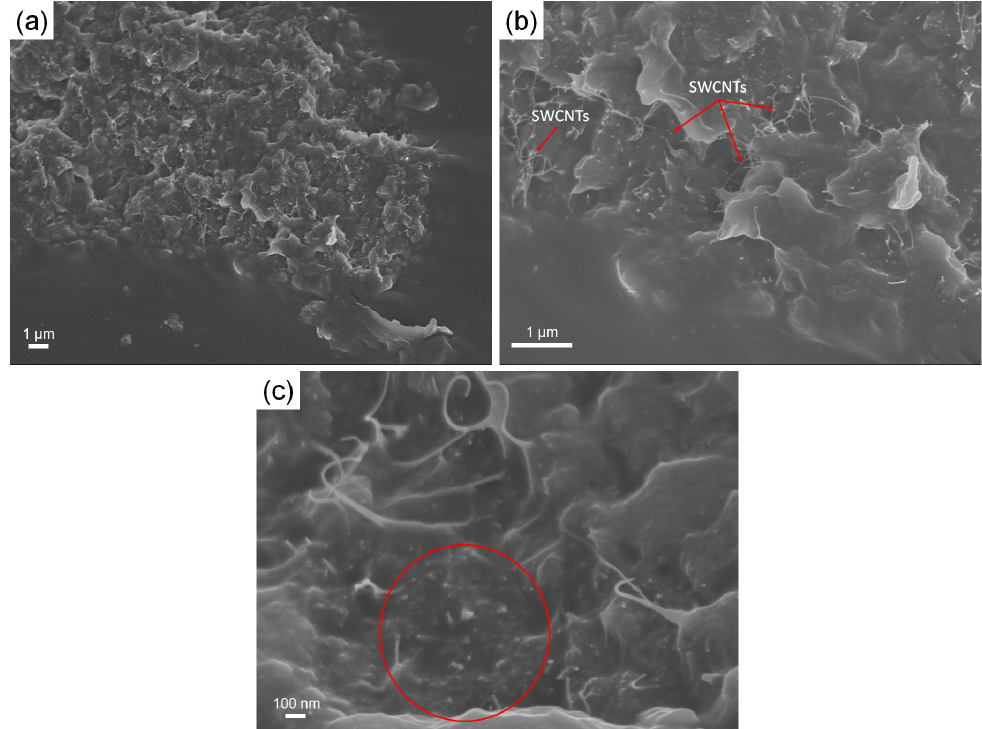
Figure 4. SEM images of NR-DCP-SWCNTs composite at different magnifications. ( a ) Distribution of SWCNTs into NR matrix, ( b ) red arrows show individualized and dispersed SWCNTs, ( c ) the red circle shows well-embedded SWCNTs in the matrix.